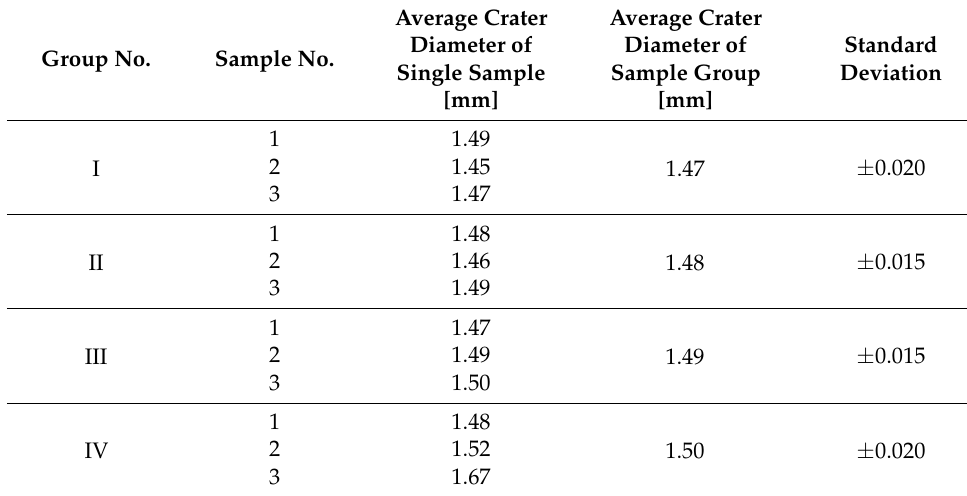
Table 6. Crater diameters measured in individual samples.